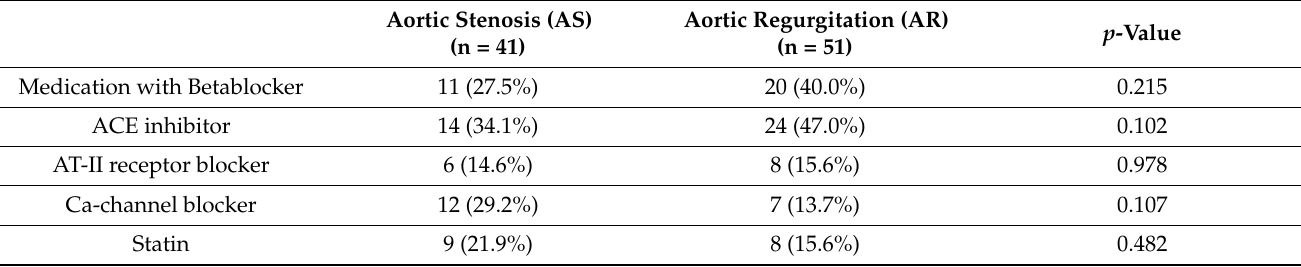
Table 2. Preoperative medication of patients with aortic stenosis (n = 41) and regurgitation (n = 51).